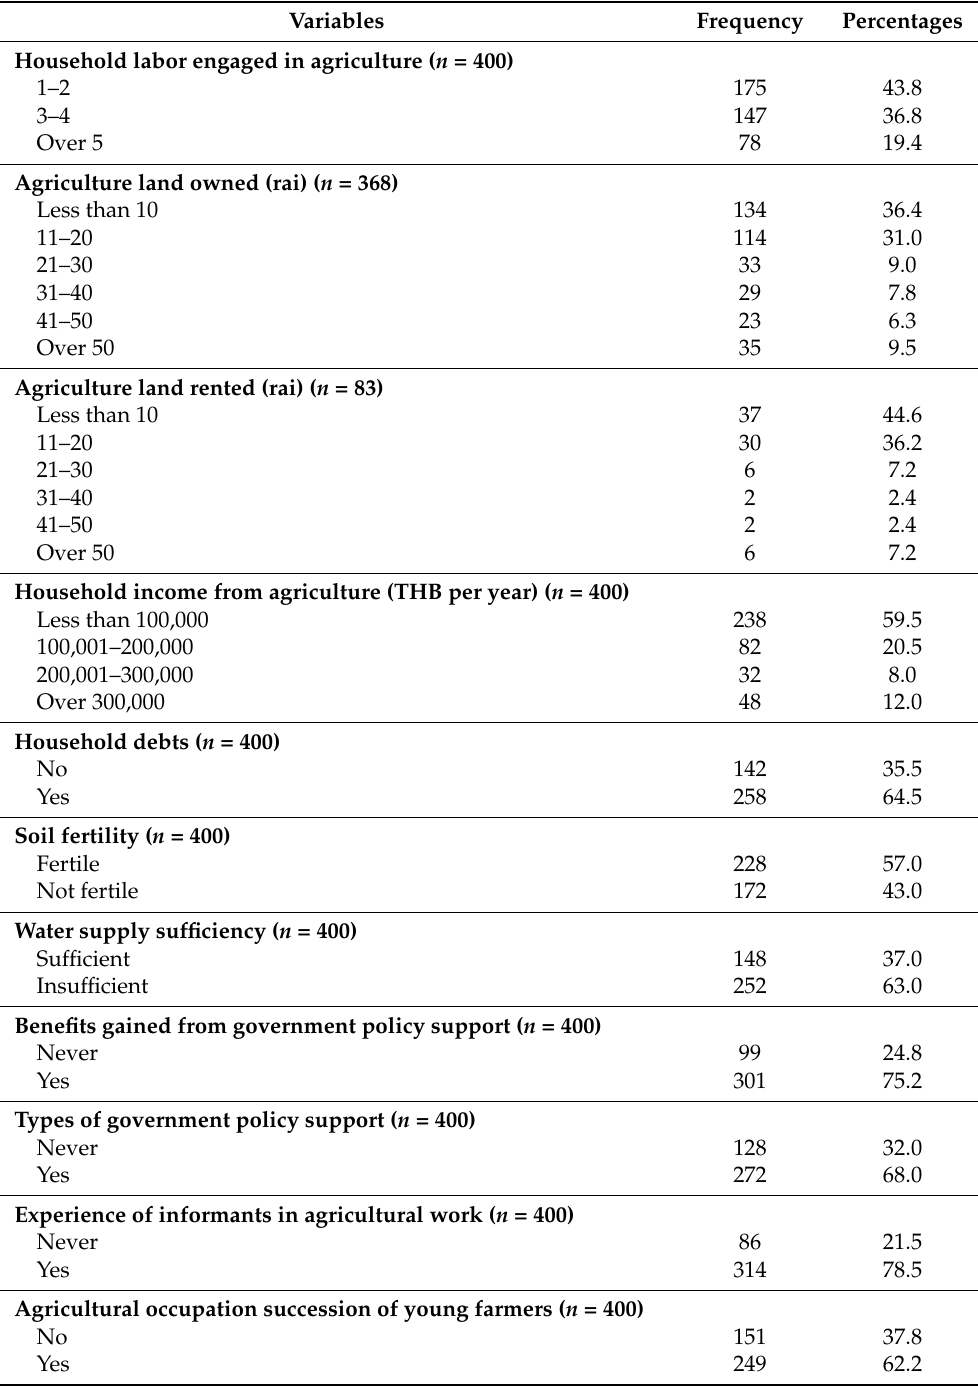
Table 2. Profile of household